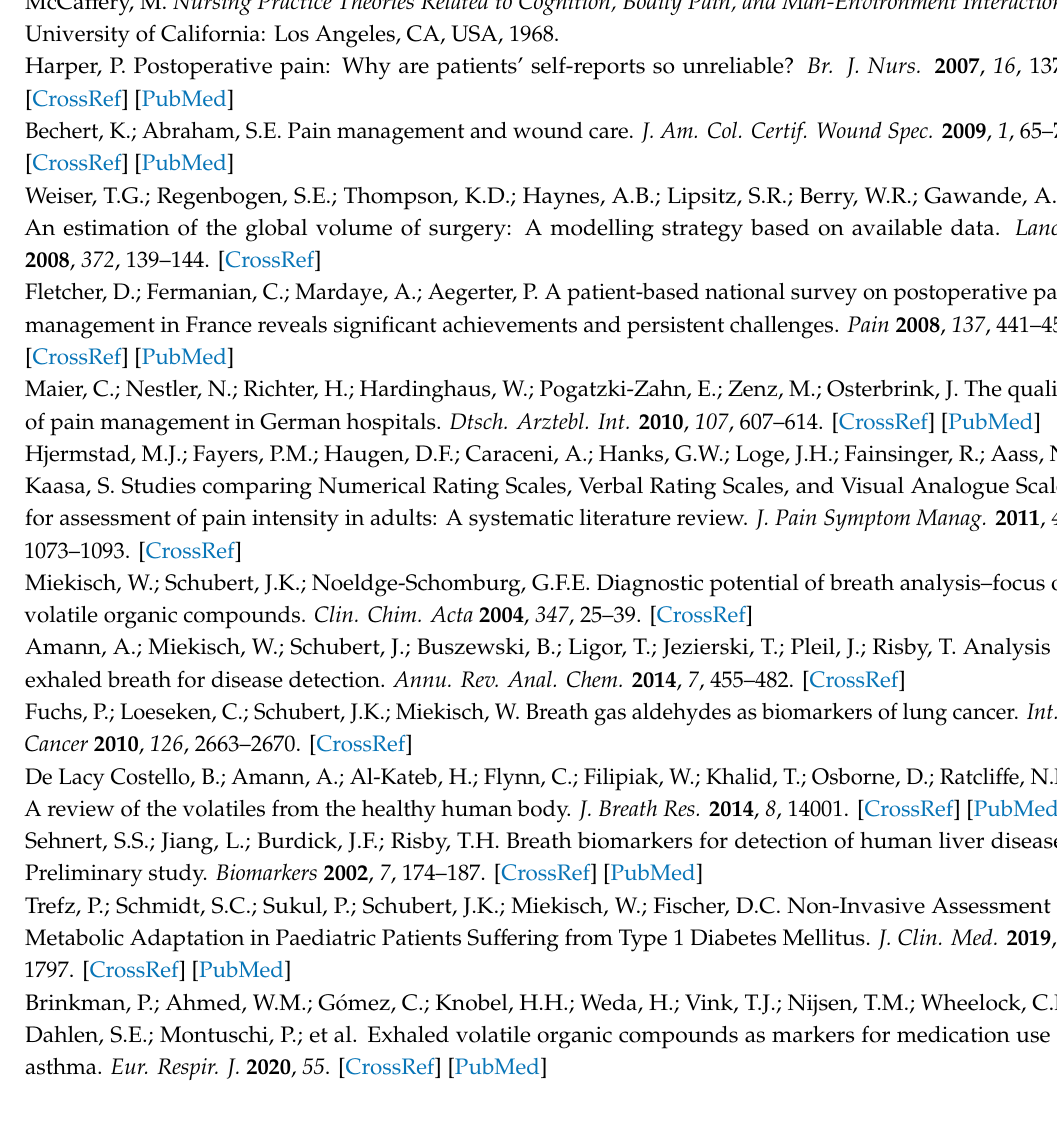
Table S1: Individual pre-existing conditions and the specific indications for the performed surgeries for each patient. Table S2: Relative changes of VOCs over time. Table S3: Cardiovascular variables during analgesic treatment. Table S4: Results of correlation analysis for the variables “catecholamine levels”, “cardiovascular variables”, and “alterations of VOC levels” using Pearson’s correlation test. Figure S1: Changes in cardiovascular variables during analgesic treatment for each patient